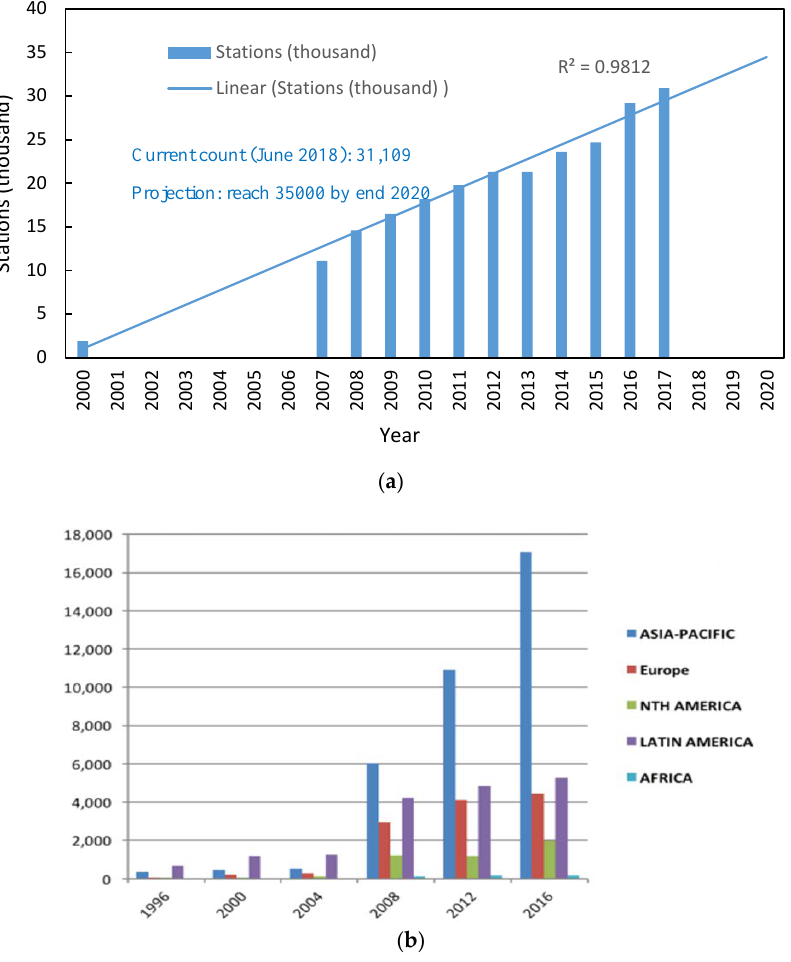
Figure 5. The number of natural-gas fueling stations: ( a ) worldwide and its projection; ( b ) growth by region [78].